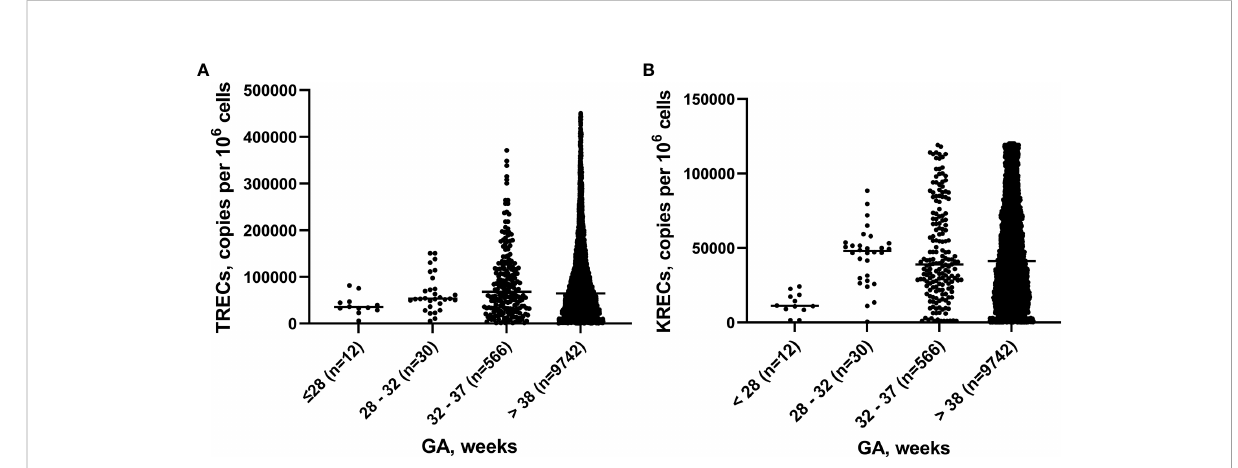
FIGURE 2 TRECs (A) and KRECs (B) (copies per 10 6 cells) in newborns depending on gestation age (GA).